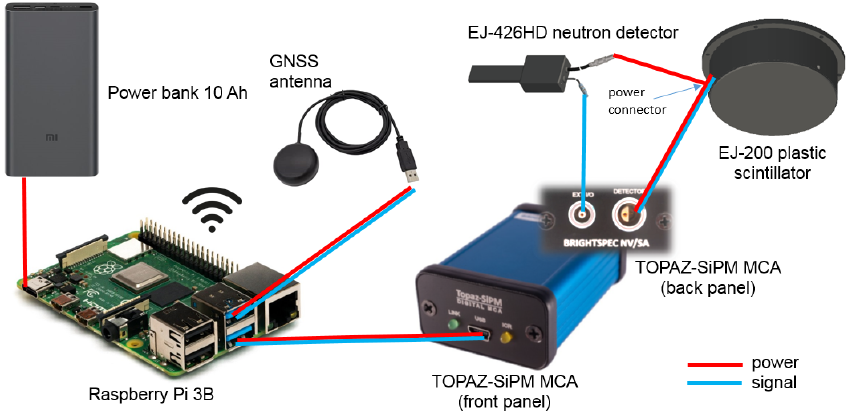
Figure 1. Hardware architecture. Equipment sizes are not at the same